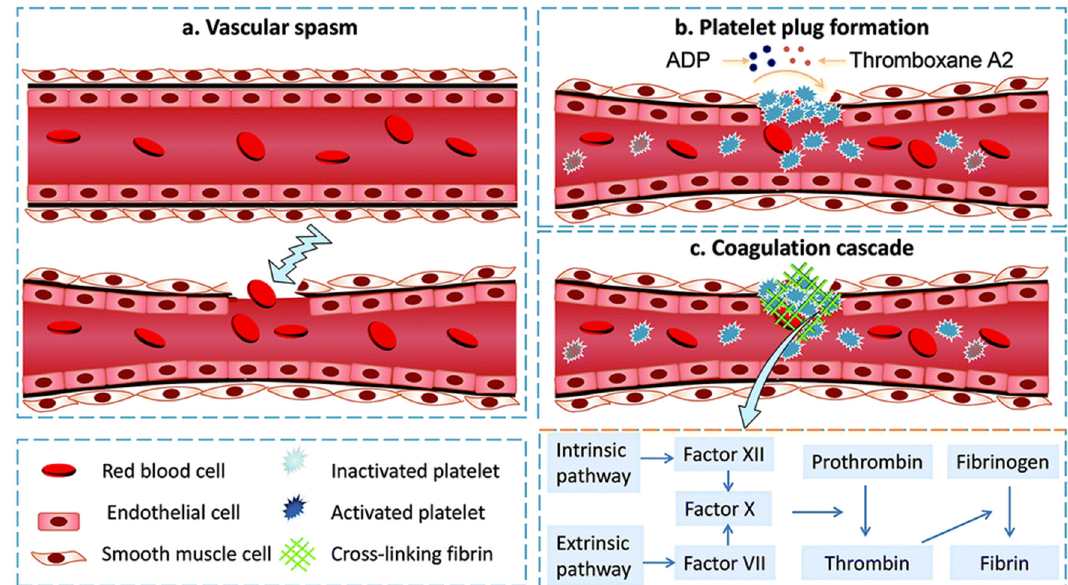
Figure 2. Schematic diagram of the hemostatic process: ( a ) vascular spasm. Immediately after injury, blood vessels are stimulated to constrict to reduce blood loss; ( b ) platelet plug formation. Once platelets are activated, the shape changes, releasing serotonin, ADP, and thromboxane A2, etc., causing more platelets to concentrate at the site of injury to form a thrombus; ( c ) coagulation cascade. Endogenous and exogenous coagulation pathways are activated, involving the interaction of factor (XII) and coagulation factor VII in the blood, with the two pathways eventually converging into a common pathway that activates factor X, which further converts prothrombinogen to thrombin. The generated thrombin activates Factor XIII, which promotes the conversion of fibrinogen into fibrin chains for hemostasis. Figures modified from [11] with permission. Copyright 2020.